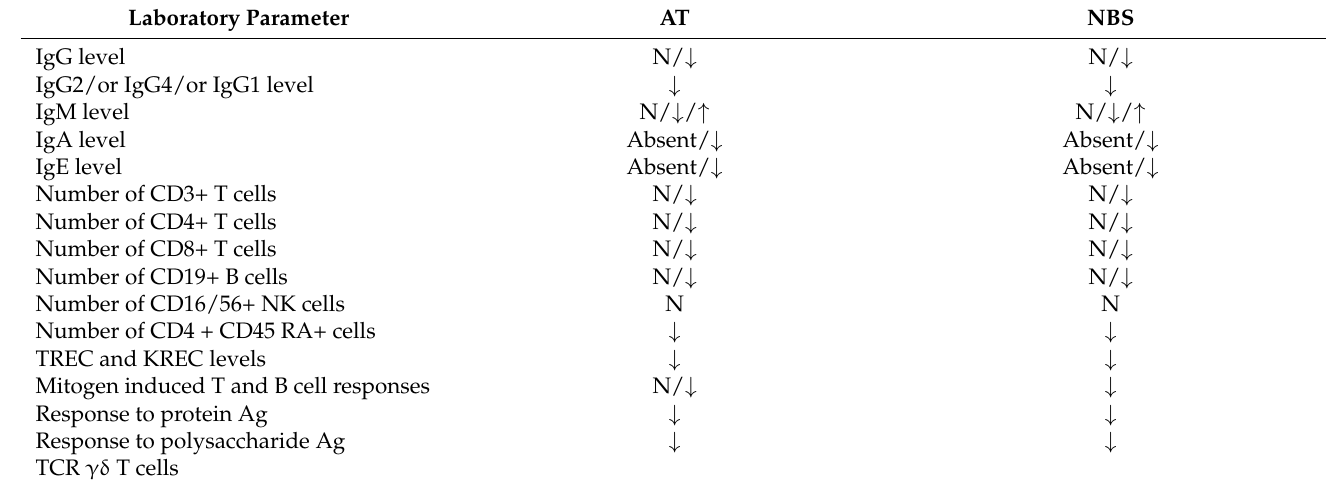
Table 1. Immunological abnormalities in patients with double stranded DNA repair